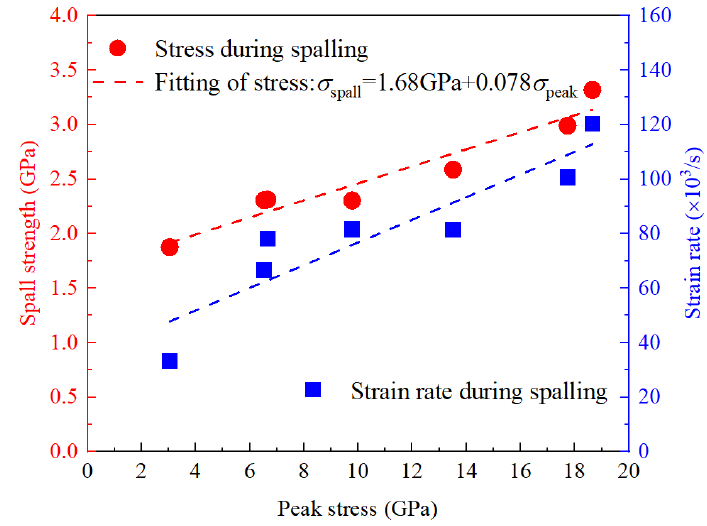
Figure 6. Calculated values of spallation strength and tensile strain rate at different impact velocities for the HSLA.